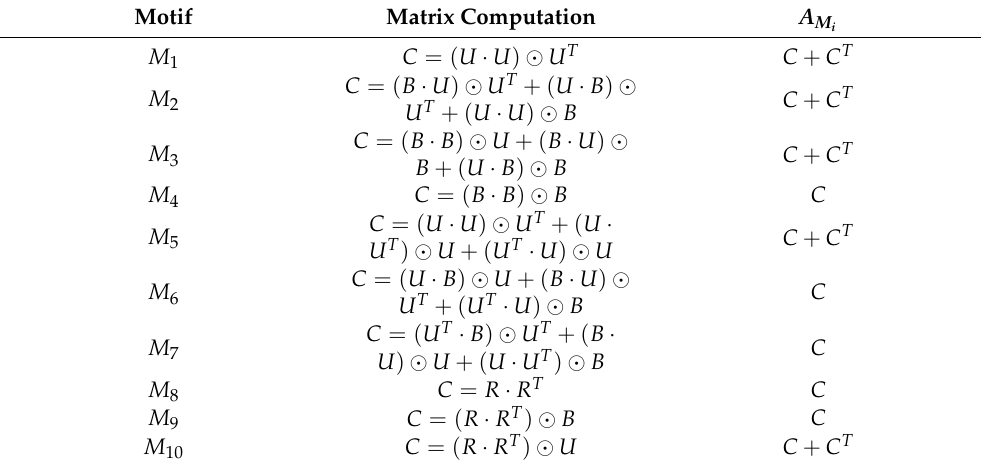
Table 1. Computation of motif-based adjacency